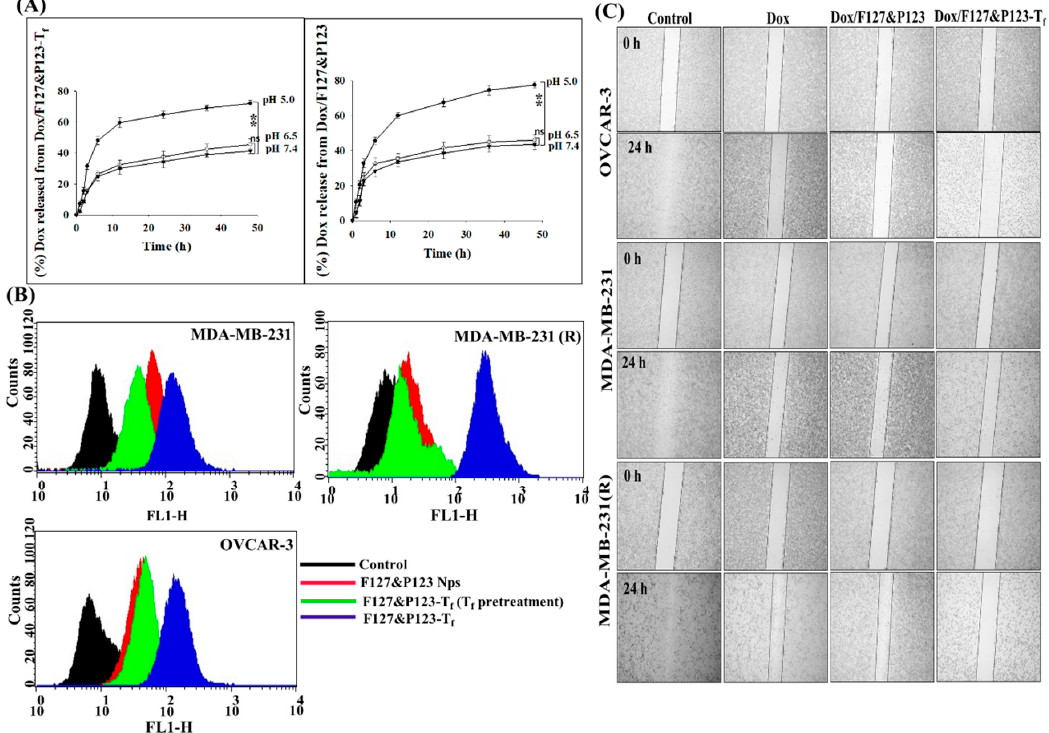
Figure 3. ( A ) In vitro release profiles of Dox from Dox/F127&P123 and Dox/F127&P123-T f in ABS (pH